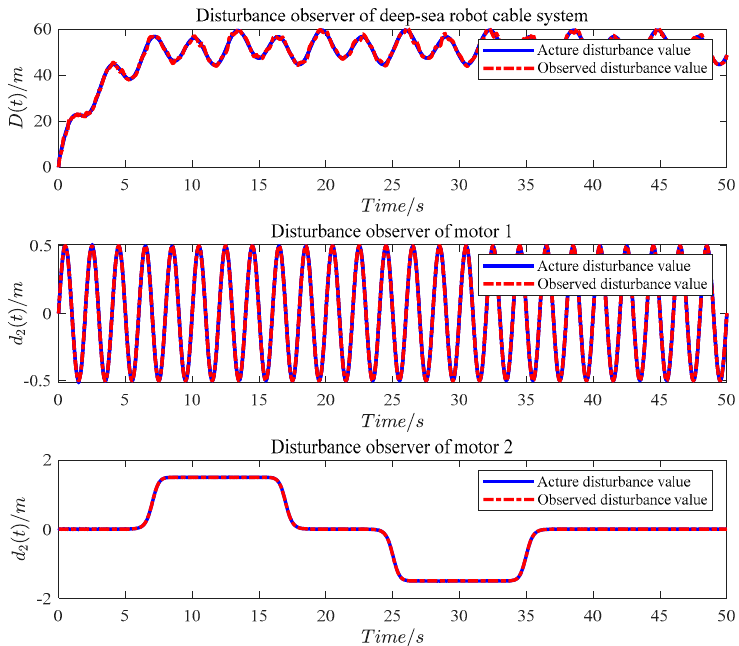
Figure 9. Actual and observed values of the disturbances in MDRCS.